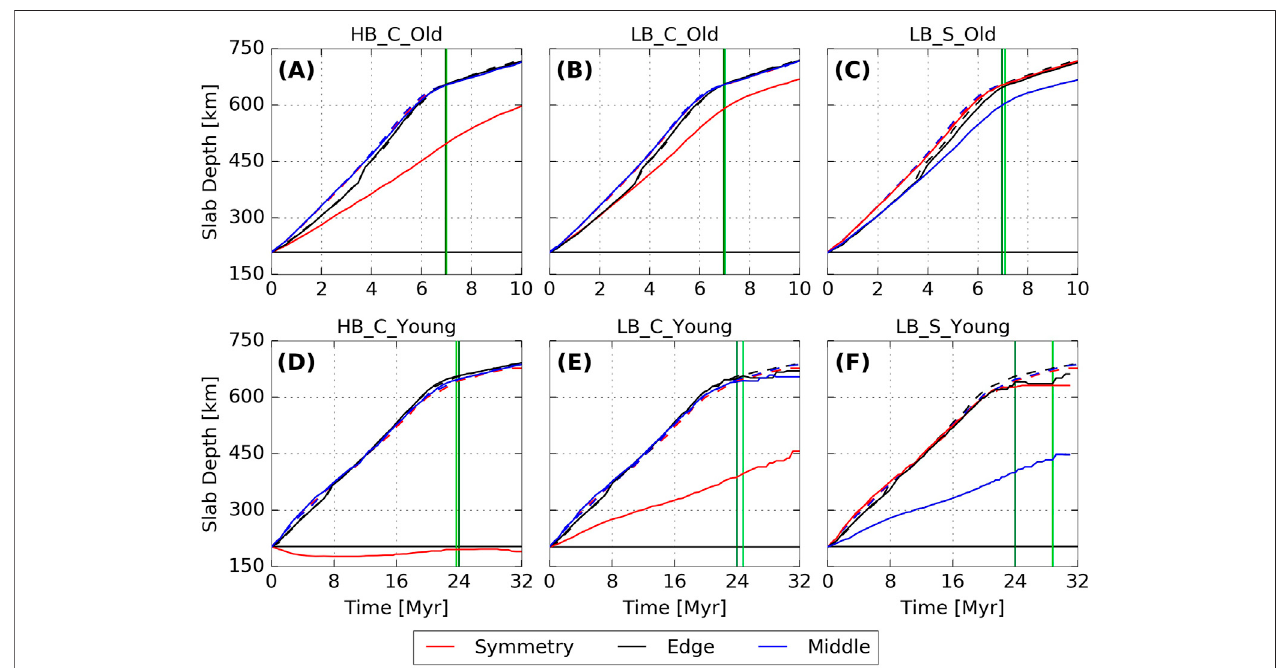
FIGURE 4 | Slab depth as a function of time for old plate models in panels (A – C) and young plate models in panels (D – F) . Dashed lines represent motions of the corresponding reference model without a ridge (cases NR_Old and NR_Young). Red lines are for measurements at the symmetry boundary [also ridge location in (A,B, D,E) ], blue lines are for measurements in the middle of the half-plate [also ridge location in (C,F) ] and black lines for measurements at the edge of the plate. Z-positions (along strike) where sinking was measured are marked on Figure 3 . Vertical lines mark the time that the slab reaches ULMB (i.e. t 660) for the ridge model (light green) and the reference cases (dark green). Solid horizontal black line corresponds to the initial depth of the slab tip at 200